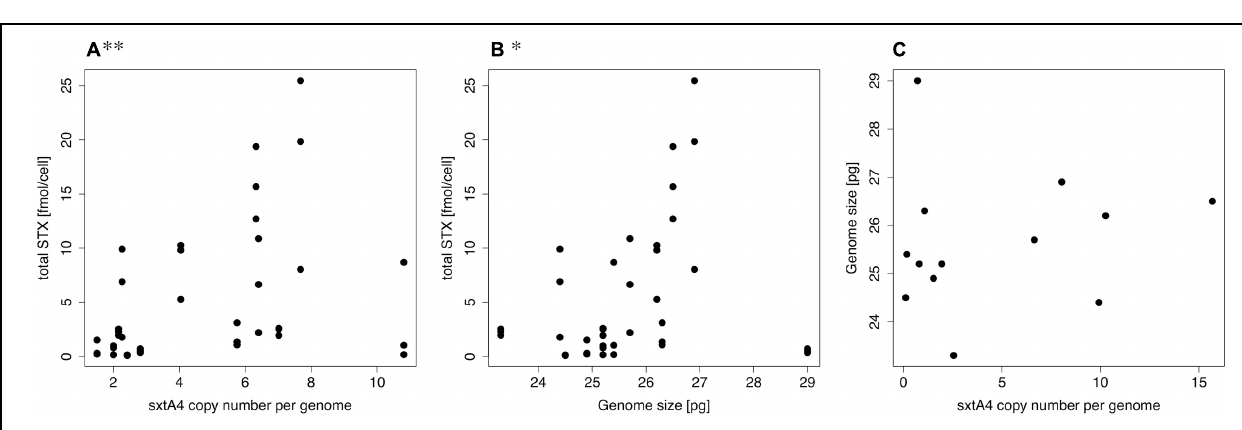
clear, but may be related to ploidy differences. In this case, sxtA4 CPN would not be a positively selected trait but rather a result of genome